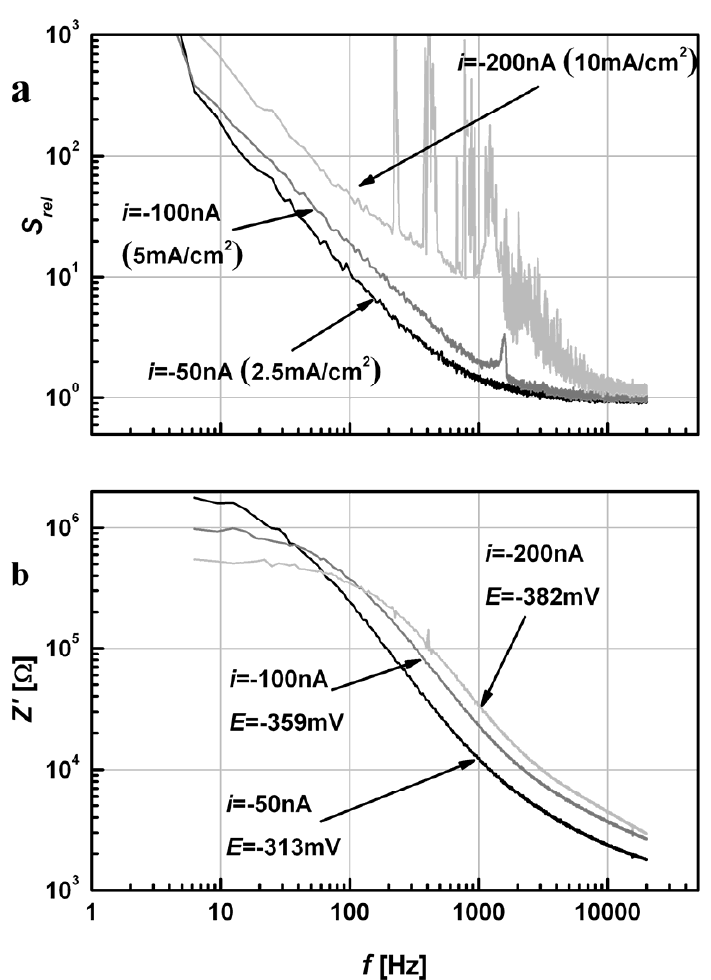
Fig. 4 Relative power spectral density ( a ) and real part of impedance ( b ) measured on d = 50 μ m Cu microelectrode in a 0.5 M H 2 SO 4 aqueous solution for three different external